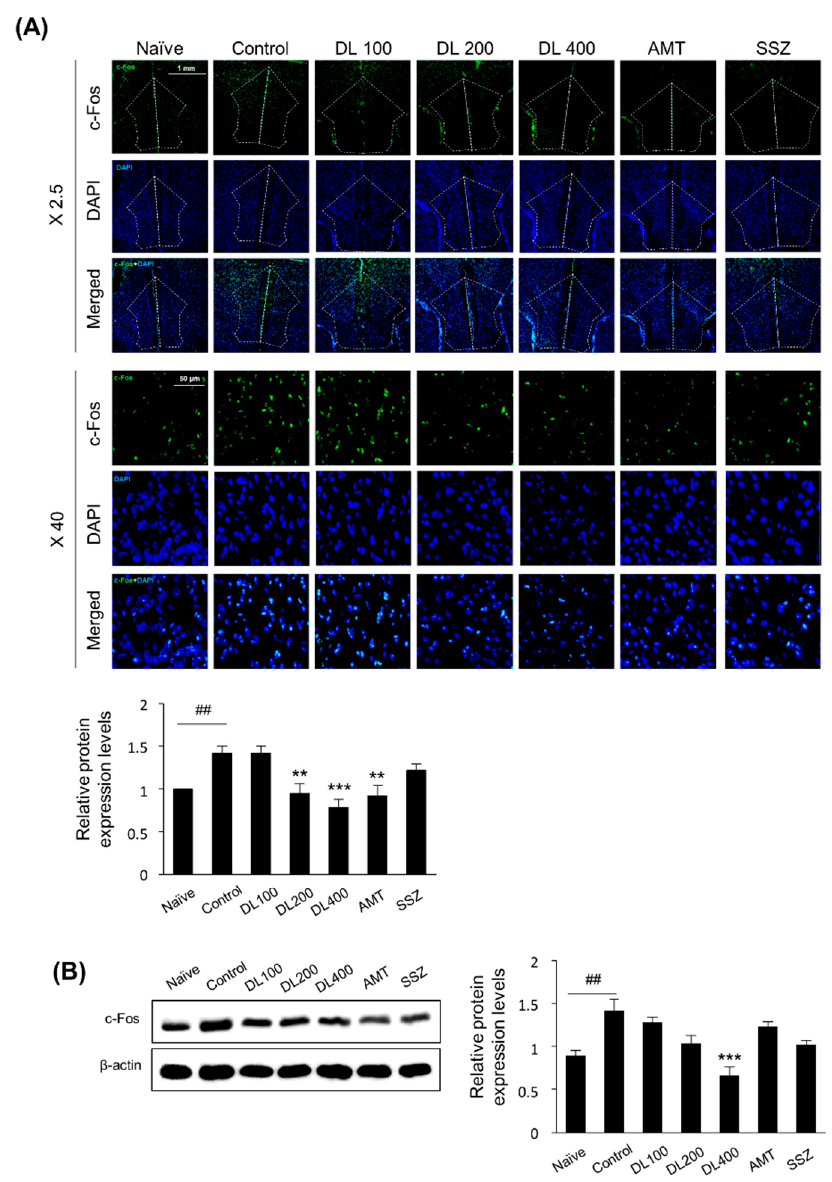
Figure 7. Effects of DL on c-Fos protein expression in the prefrontal cortex of zymosan-induced IBS mice. ( A ) IF staining was performed to determine c-Fos expression in the prefrontal cortex (1.78 mm before the bregma). The frozen sections were stained with c-Fos antibodies (green) and evaluated by confocal microscopy. The dashed line indicates the location of the prefrontal cortex. The protein level of c-Fos was quantified by ImageJ software. ( B ) Prefrontal cortex lysates were analyzed by Western blotting using c-Fos antibodies. Band density was analyzed by ImageJ software. β -actin was used as the loading control. Data are presented as a mean ± standard deviation ( n = 4, one-way ANOVA; ## p < 0.01 vs. naïve; *** p < 0.001 vs. control). DL, D. lablab L. extracts; AMT, amitriptyline; SSZ, sulfasalazine; IF, immunofluorescence; DAPI, 4 (cid:48)